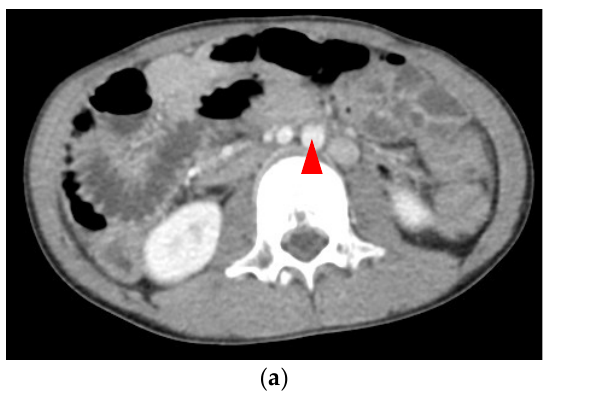
Figure 3. CT of the abdomen showing that the liver is full in the midline of the abdomen: ( a ) the hypodense tumor is located in the right abdomen <star>, and the superior mesentery vein <arrow head> lies to the left of the superior mesentery artery; ( b ) seven arrowhead spleens <arrows> are suspected beside the tumor (all spleens cannot be shown in two pictures). See the complete series of CT in Supplementary Materials Figure S1: CT of abdomen.